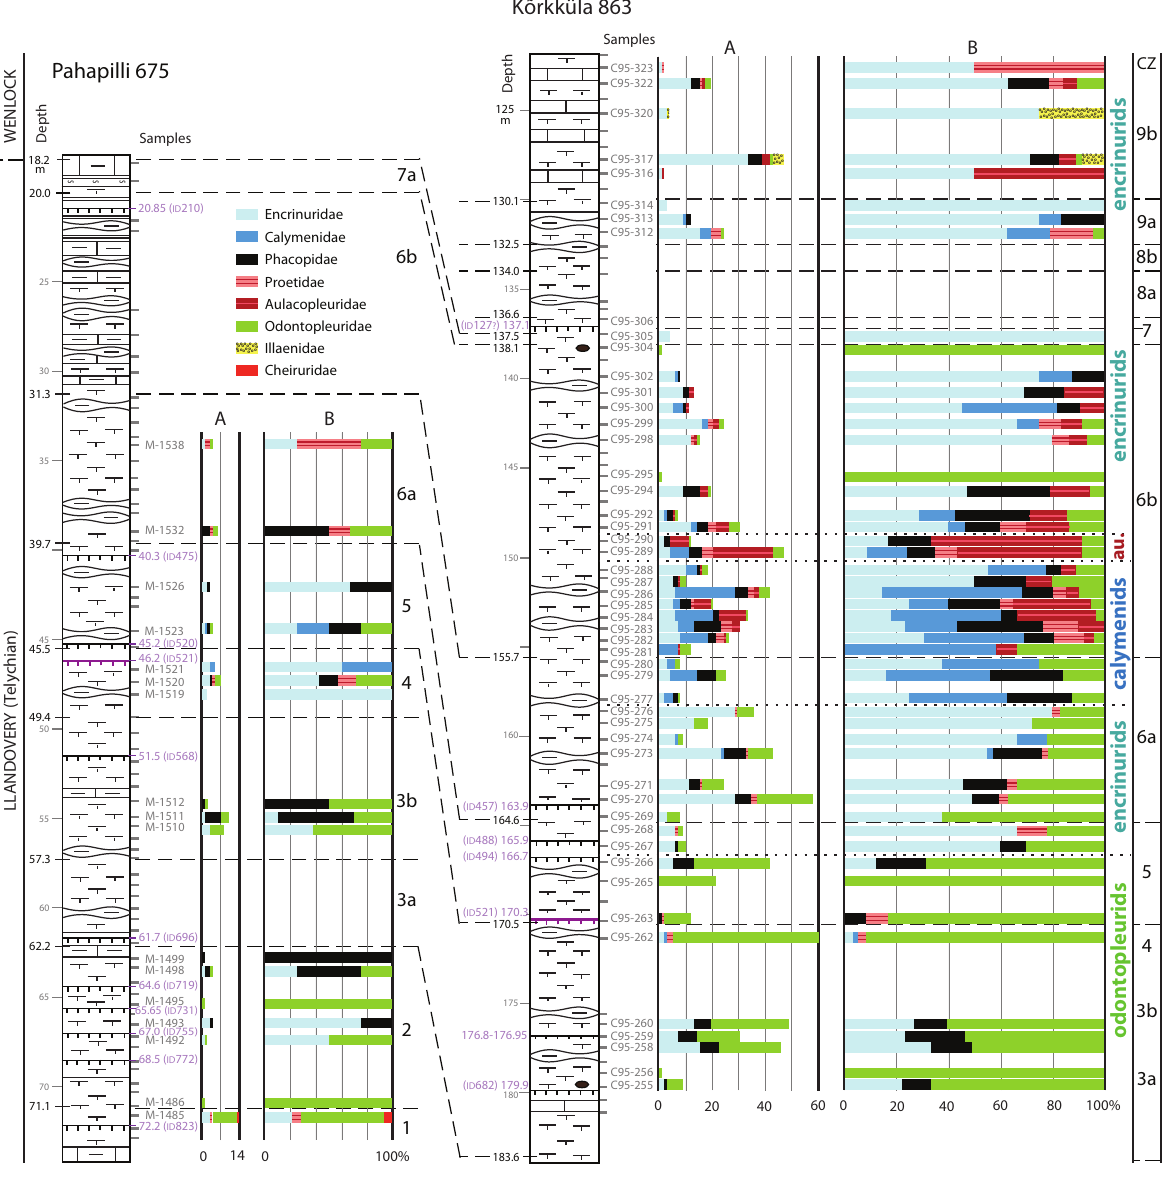
Fig. 6 . Trilobite associations in the Pahapilli 675 and Kõrkküla 863 sections. Number of specimens by samples (A), and composition of trilobite fauna in samples by the percentage of different trilobite families (B). ID numbers next to the logs mark the volcanic ash beds (see Kallaste and Kiipli 2006). For the legend and explanation of indexes, see Figs 2 and